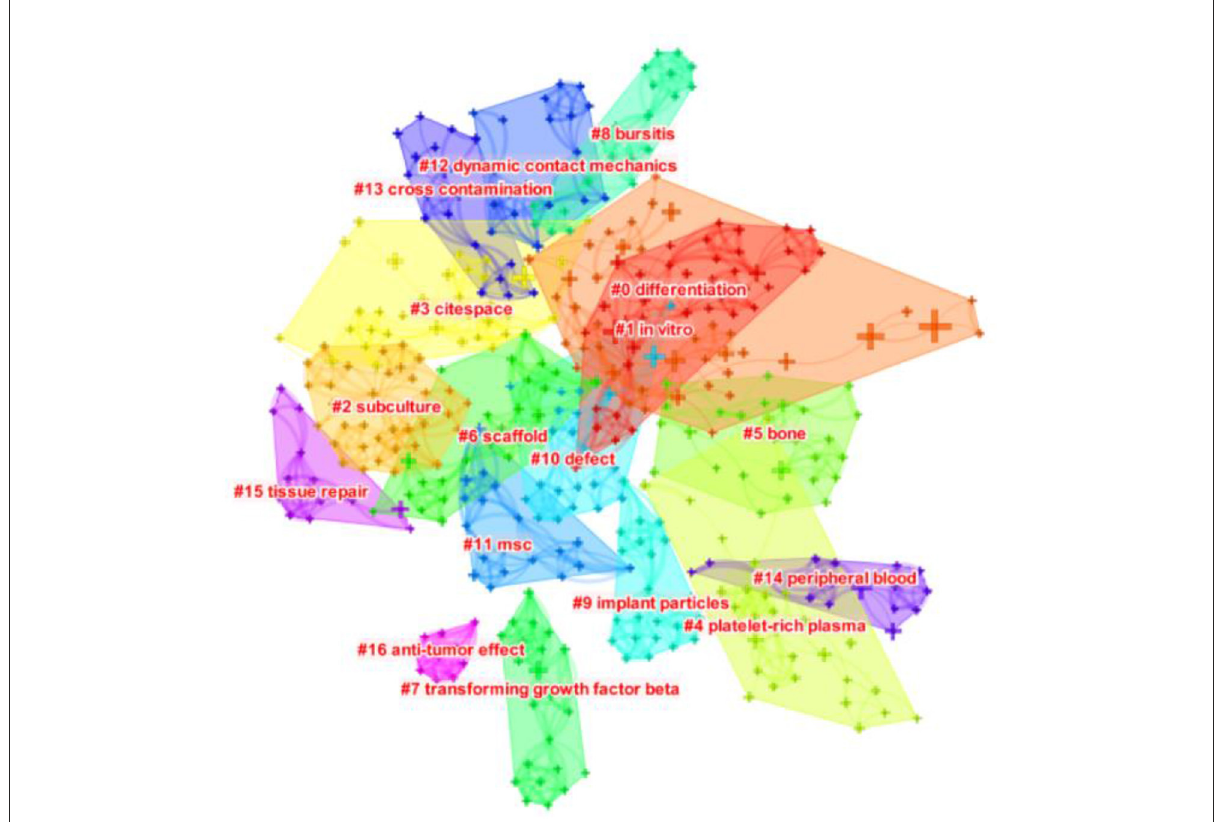
FIGURE7 The clustering map of keywords related to MSCs in orthopedics from 2002–2021. The different colored squares in the figure represent different